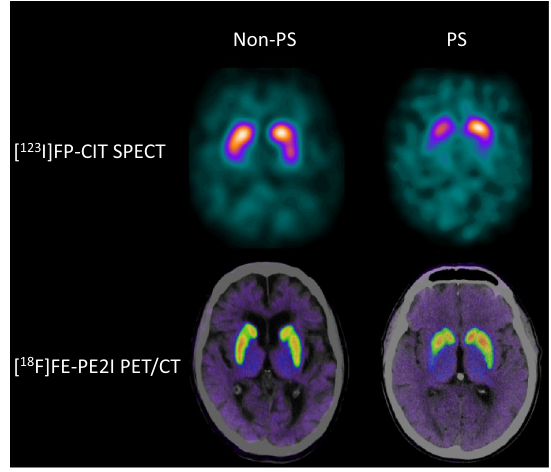
Fig. 2 Sample images of two patients evaluated with [ 123 I]FP-CIT SPECT and [ 18 F]FE-PE2I PET. PS: Parkinsonian syndromes